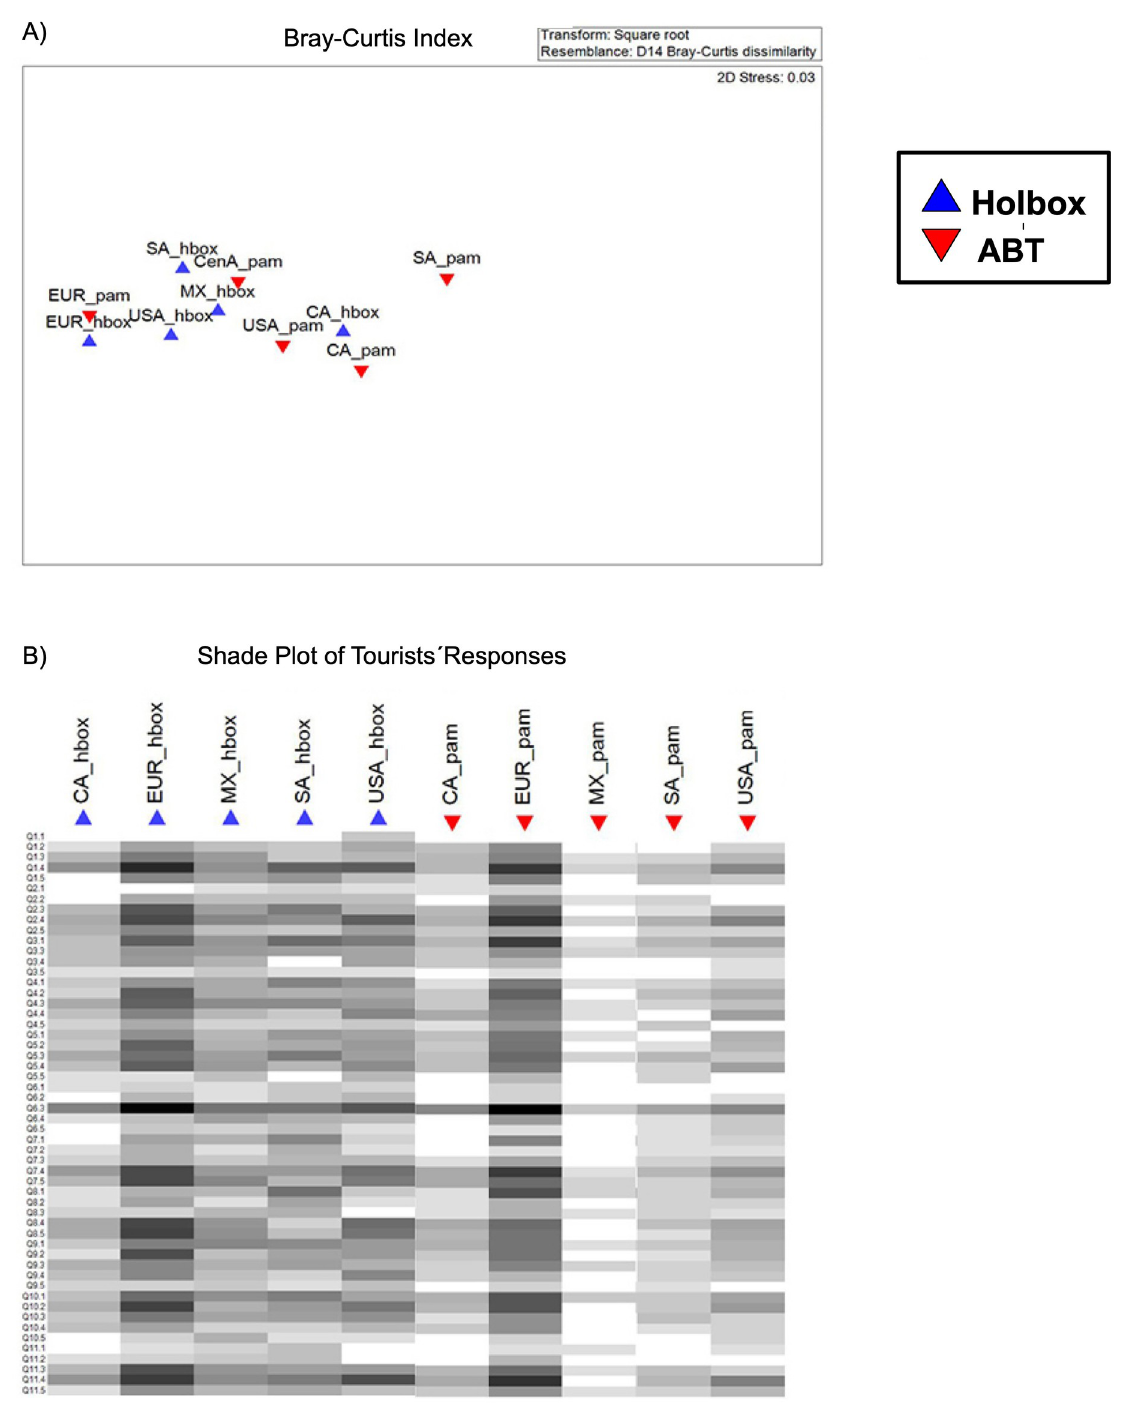
Fig 8. (A) Heatmap of tourists" responses between Holbox and the ABT. (B) Bray-Curtis non-parametric analysis. A presence-absence matrix of tourists’ responses as descriptors and geographic sites as units of the analysis was used.